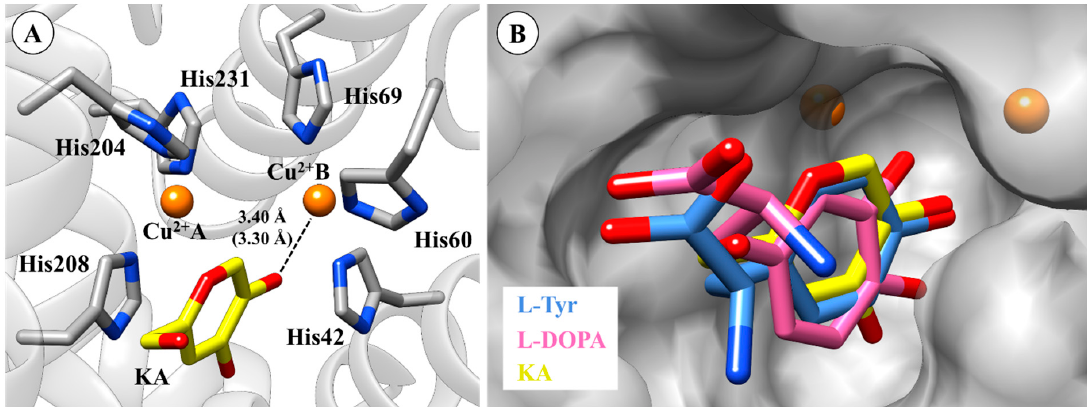
Figure 4. Binding mode of KA (kojic acid) ( A ) in the active site of tyrosinase (TYR) and ( B ) overlapping of L -Tyr, L -DOPA, and KA. Crystal (in parenthesis) and docking distances are reported in ångström (Å). The 3D structures of the molecular docking results are available in Protein Data Bank (PDB) format in the Supplementary Materials.